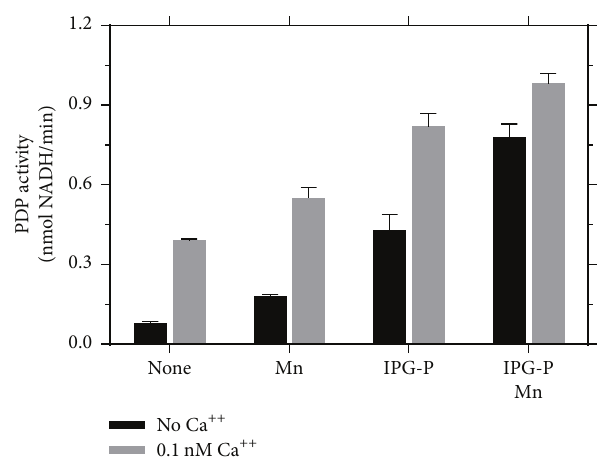
Figure 5: Pyruvate dehydrogenase phosphatase (PDP) can be activated in presence of calcium. This effect is boosted by inositol phosphoglycans P-type (IPG-P) and